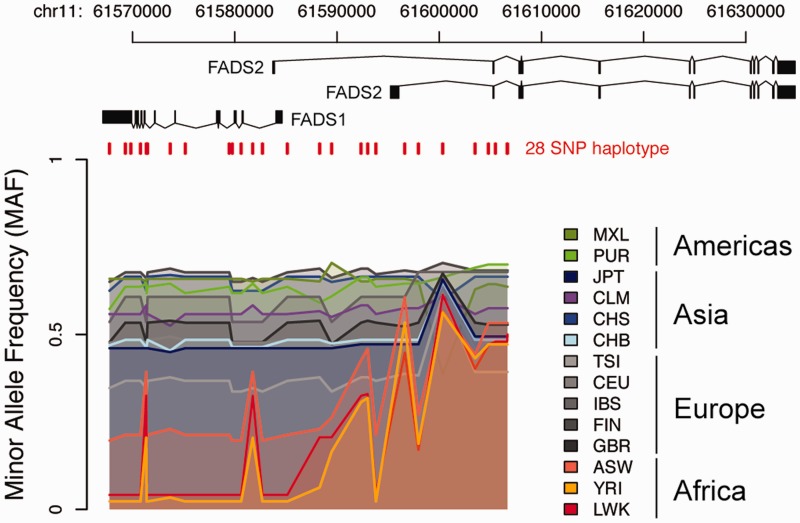
Visualization of 10 000 Genomes data in a specific region. The colored lines show the Minor Allele Frequencies (MAF) in different 1000 Genomes populations for 28 SNPs on a haplotype, denoted haplotype D, over the FADS region on chromosome 11. At the top are the transcript isoforms of FADS1 and FADS2. Red vertical lines mark the genomic positions of the 28 SNPs on haplotype D. Haplotype frequency varies between populations having ancestry on different continents, with lowest MAF seen in populations with African ancestry and highest MAF in American populations.